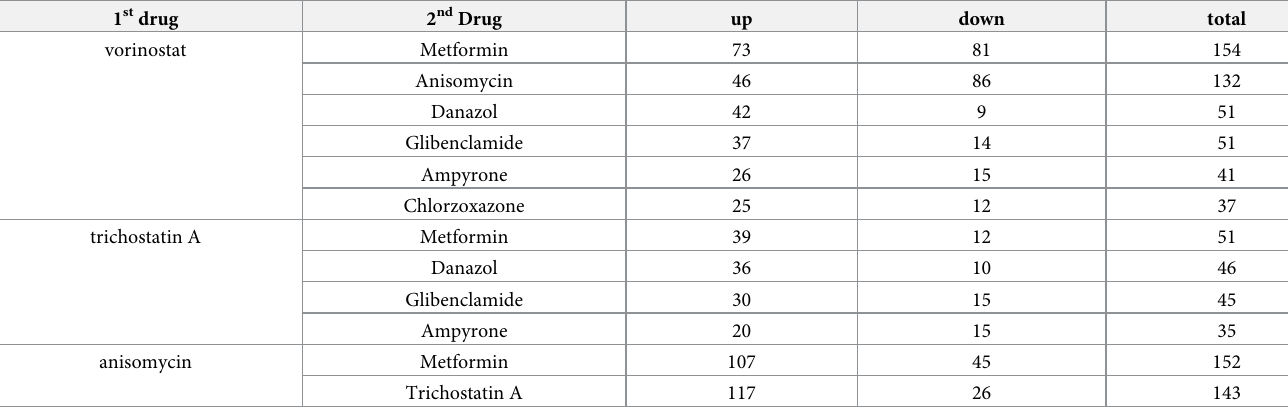
nuclear morphology to a more spherical shape by 32% in comparison with the experimental control. ( � p < .05) Furthermore, combinatorial drug treatment produced nuclei that were about 25% more circular compared with those treated independently with the first or second round drugs (Fig 5A and 5B, and S6A Fig). ( � p < .05) The treatments of glibenclamide in com- bination with trichostatin A or vorinostat decreased the nuclear shape alteration rate most markedly. Still, the randomly combined treatment did not reduce the nuclear shape alteration significantly. However, an unexpected combinatory treatment of vorinostat with trichostatin A showed an average efficiency of 41% (S6B Fig). ( � p < .05) Combination drug treatment restored the nuclear morphology to a spherical shape compared to first drug only treatment. Identify of anti-aging effect by senescence-associated beta-galactosidase staining Senescence-associated beta-galactosidase (SA- β -gal or SABG) is a hypothetical hydrolase enzyme that catalyzes the hydrolysis of beta-galactosidase into monosaccharides only in senes- cent cells. Senescence associated beta-galactosidase is regarded to be a biomarker of cellular senescence. The alteration of senescent cell numbers was validated with beta-galactosidase staining (S7 Fig). HL-60 cells were co-treated with trichostatin A, vorinostat, anisomycin with combinatorial drug pairs for 36 h after incubation with 10 μ M H O . The percentage of beta- 2 2 galactosidase positive cells treated with the first-round CMap drugs (trichostatin A, vorinostat, anisomycin) is slightly decreased compared with their levels in the experimental control (10 μ M H O only). The percentage of trichostatin A and danazol or trichostatin A and ampyr- 2 2 one combination-treated cells were decreased 48–51% compared with their levels in the first- round drug-treated cells (Fig 6A and 6B, and S8A Fig). ( �� p < .01) However, the percentage of Table 3. Drug combinations suggested in 2nd